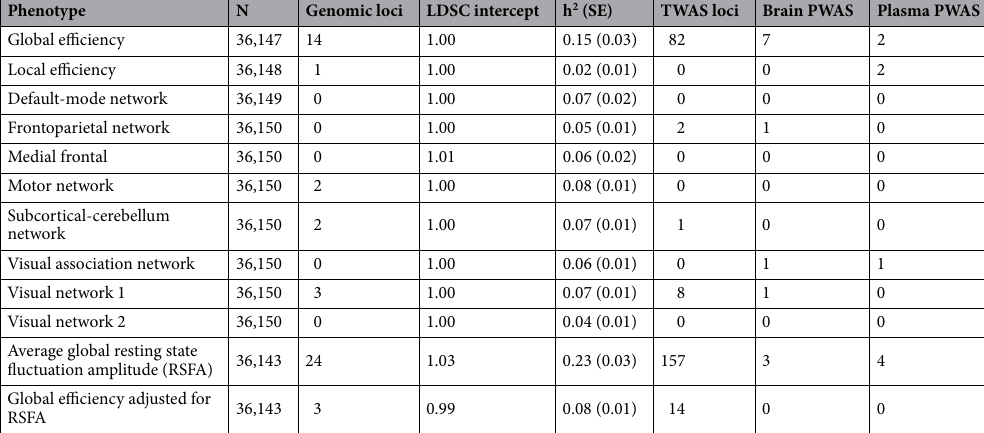
Table 1. Overview of results for each network phenotype analysed. N, number of individuals included in the analysis; LDSC, linkage disequilibrium score regression; h 2 , heritability; SE, standard error; TWAS, transcriptome -wide association study; PWAS, proteome-wide association